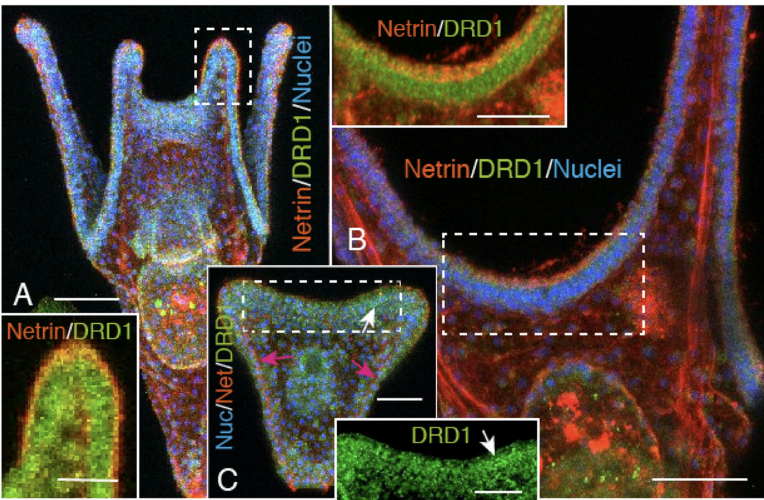
Figure 6. Confocal laser scanning microscopy of the Netrin stripe formed on the oral side of the DRD1-expressing ciliary band in 4aPL, and lack of the Netrin stripe in very early 2aPL. ( A ) Aboral side view. A Netrin-positive signal is detected on the apical side of the DRD1-expressing circumoral ciliary band. Inset: higher magnification of the right antero-lateral arm shown by a rectangle in (A). ( B ) Oral side of the post-oral CBAS. Inset: Netrin / DRD1 stained image of the rectangle in (B) shows a partially overlapped Netrin stripe and DRD1-positive ciliary band. Inset: Netrin stripe on the circumoral ectoderm side of the DRD1-positive ciliary band. ( *C ) Close to the end of the prism stage. The DRD1-positive ciliary band is not associated with the Netrin stripe but remained in the blastocoel (red arrows) in this developmental stage. Inset: higher magnification of the ciliary band region (arrow) shown by the rectangle in (C). Scale bars = 50 µ m (A), 25 µ m (insets of A and C), 30 µ m (B, C), 15 µ m (inset of